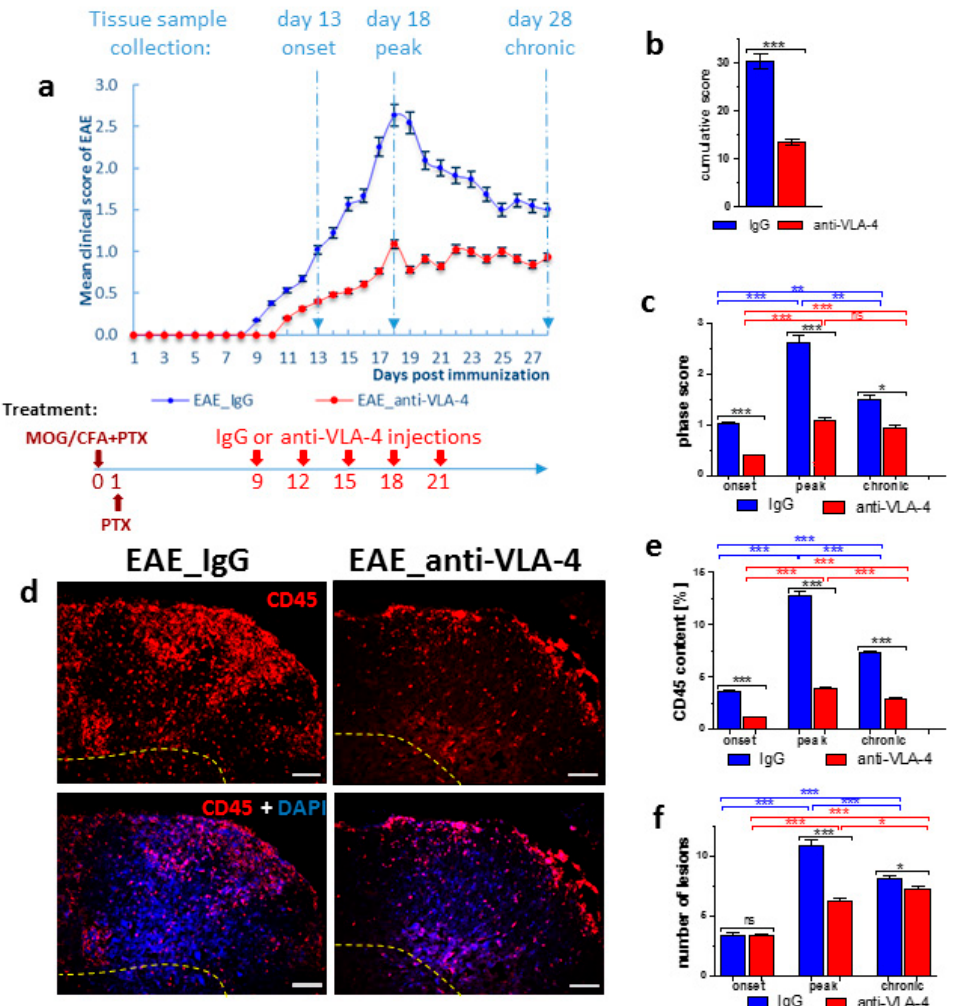
Figure 2. EAE mice were immunized with MOG and CFA (day 0) and PTx (day 0 and 1) ( a , brown arrows). The clinical scores of EAE were assessed in experiments in which immunized mice were treated with IgG ( a , blue points) or anti-VLA-4 mAb ( a , red points) every third day for 12 days ( a , red arrows). Days of tissue collection and disease phases are indicated ( a , upper part). Histograms show the cumulative clinical score (means ± SEM) for IgG and anti-VLA-4 mice ( b ) and mean score in onset, peak and chronic phases of EAE ( c ). CD45 immunostaining of spinal cord sections shows inflammatory infiltration in the peak phase of EAE for IgG and anti-VLA-4 groups (in all micrographs, yellow dashed line marks the border between white and gray matter) ( d ). In order to assess inflammation degree, the area occupied by CD45 immunopositive cells was quantified as percentage of cross-sectioned cord surface area ( e ). Anti-VLA-4 treatment attenuated the disease clinical scores ( a – c ), the area of inflammatory lesions compared to IgG treatment ( e ) and the number of lesions ( f ). Data are presented as means ± SEM; n = 5 per group. nf—not found. Statistical significance was verified using a two-sided Mann–Whitney test at 0.05 confidence level (*** p < 0.001; ** p < 0.01; * p < 0.05; ns—not significant). Magnification is indicated by scale bars (=100 µm).